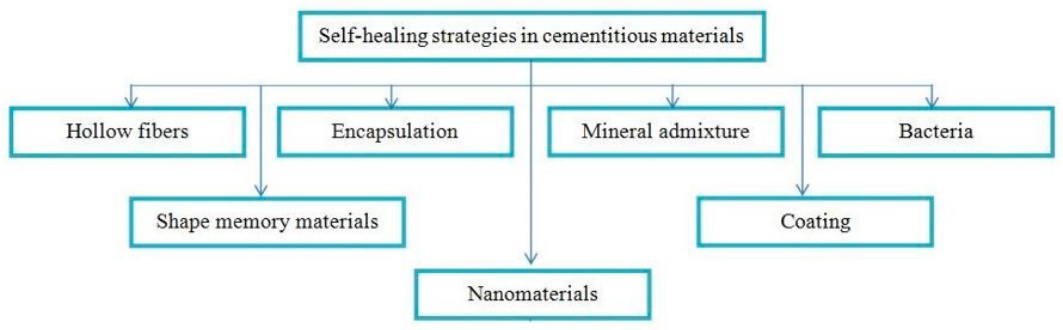
Figure 4. Developed strategies for self-healing in cement based materials.